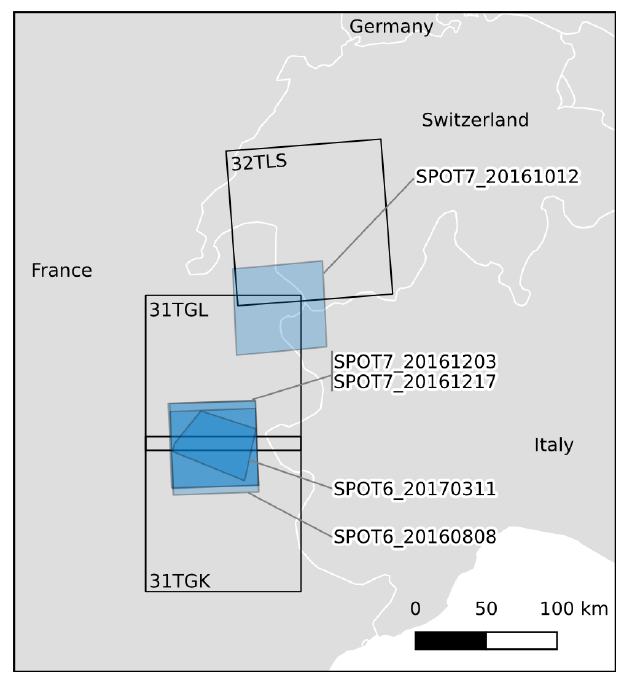
Figure 9. Location of the five SPOT-6/7 products used for the evaluation of the snow detection accuracy and the corresponding Sentinel-2 tiles (see also Table 4).